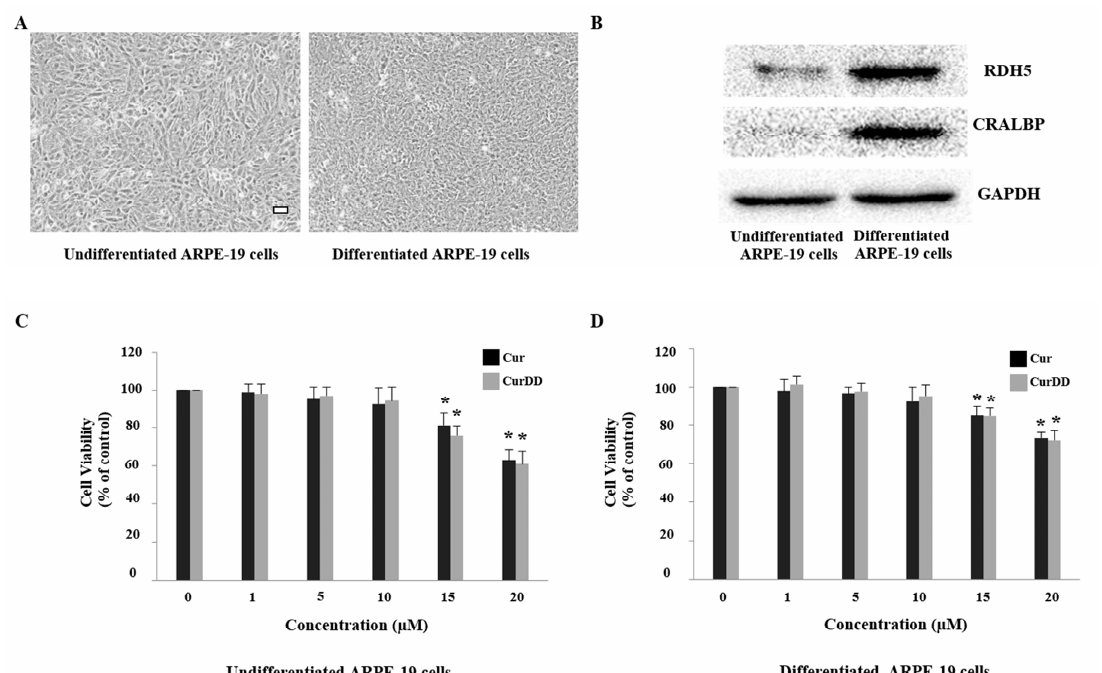
Figure 2. E ff ect of Cur and CurDD on cell viability of undi ff erentiated and di ff erentiated ARPE-19 cells. Figure 2. Effect of Cur and CurDD on cell viability of undifferentiated and differentiated ARPE-19 ( A ) Morphology by phase contrast microscopy of undi ff erentiated ARPE-19 and 3-month di ff erentiated cells. ( A ) Morphology by phase contrast microscopy of undifferentiated ARPE-19 and 3-month ARPE-19 cells. Scale bar represents 100 µ m; ( B ) Protein levels of RPE-specific markers RDH5 and differentiated ARPE-19 cells. Scale bar represents 100 µm; ( B ) Protein levels of RPE-specific markers CRALBP were assessed by immunoblotting in undi ff erentiated and di ff erentiated ARPE-19 cells. RDH5 and CRALBP were assessed by immunoblotting in undifferentiated and differentiated GAPDH immunodetection was used as a loading control; ( C ) Undi ff erentiated and ( D ) di ff erentiated ARPE-19 cells. GAPDH immunodetection was used as a loading control; ( C ) Undifferentiated and ARPE-19 cells were treated with di ff erent concentrations (range 1 to 20 µ M) of Cur or CurDD for 24 h ( D ) differentiated ARPE-19 cells were treated with different concentrations (range 1 to 20 µM) of after which cell viability was measured using MTT assay. Graphs represent average cell viability (mean Cur or CurDD for 24 h after which cell viability was measured using MTT assay. Graphs represent ± SD values, n = 4; One-Way ANOVA test, * p ≤ 0.05 vs control average cell viability (mean ± SD values, n = 4; One-Way ANOVA test, * p ≤ 0.05 vs control group).